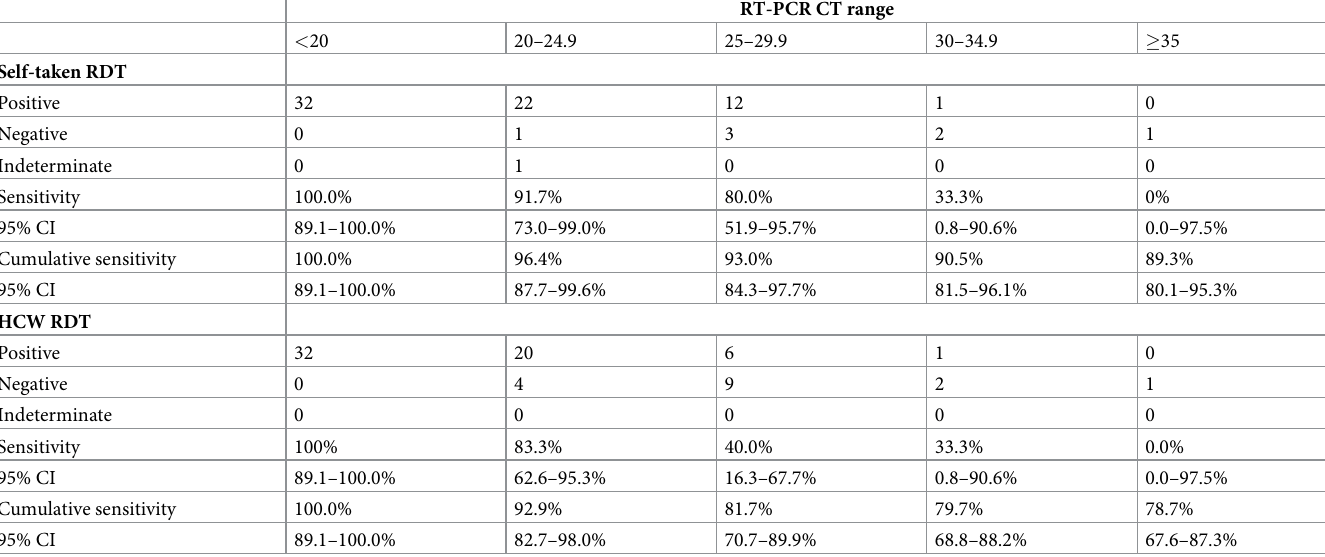
Table 4. Sensitivity of self- and healthcare worker-taken swab for rapid diagnostic testing by RT-PCR CT